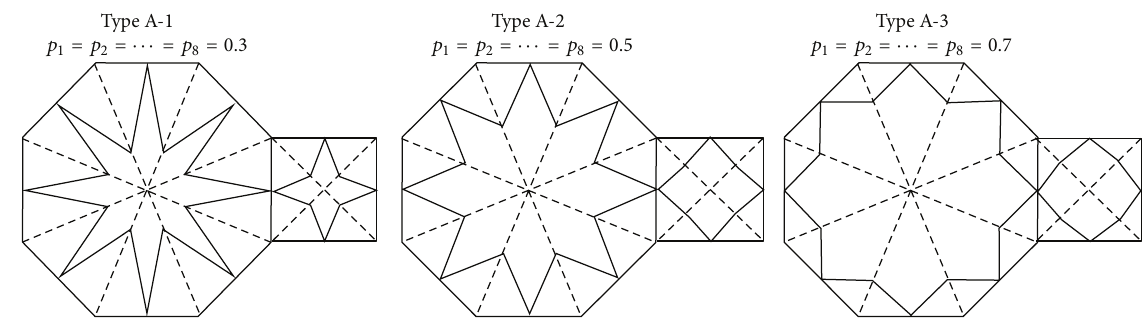
Figure 20: Examples of basic variations: Type A.